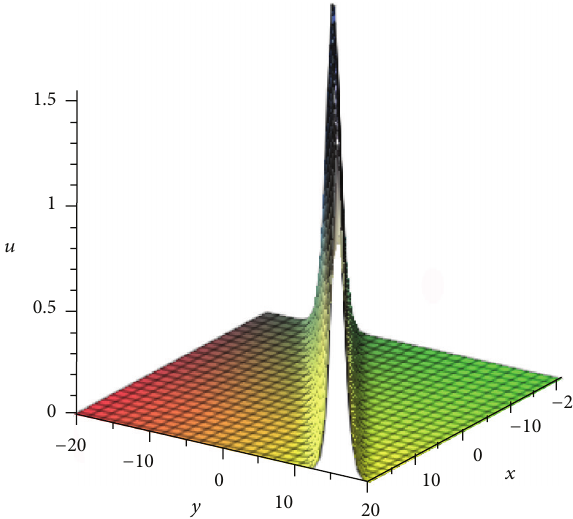
Figure 3: The shape and motion of the two-soliton solutions for 𝜔 = −1 , 𝑎 = 1 , 𝑏 = 1 , 𝑐